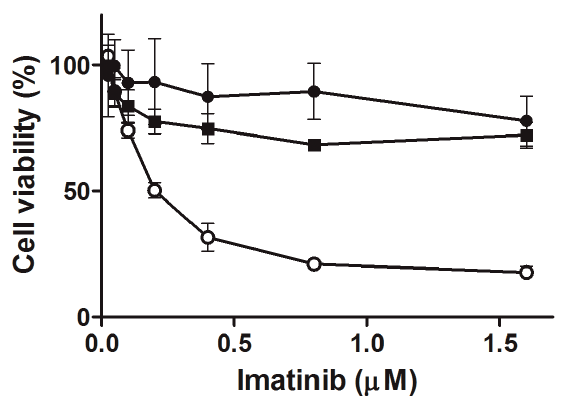
Figure 1. Relative mean viability of mouse 32D cells transfected with the BCR-ABL1 gene: sensitive (S, white circles) and resistant to imatinib as evaluated by the Cell Counting Kit-8 assay. Imatinib resistance resulted from the Y253H mutation in the BCR-ABL1 gene (black circles) or from incubation of S cells with escalating doses of imatinib (black squares). All cell lines were incubated with imatinib at 0.025–1.6 µM for 24 h at 37 °C. Presented are means of six independent measurements; error bars represent standard deviation